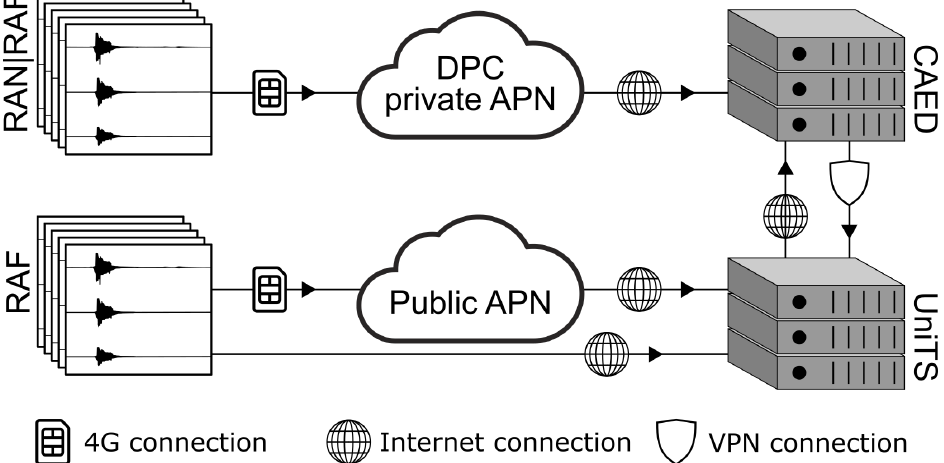
Figure 4. Schema of the Italian ground motion network RAN data transmission from the network to